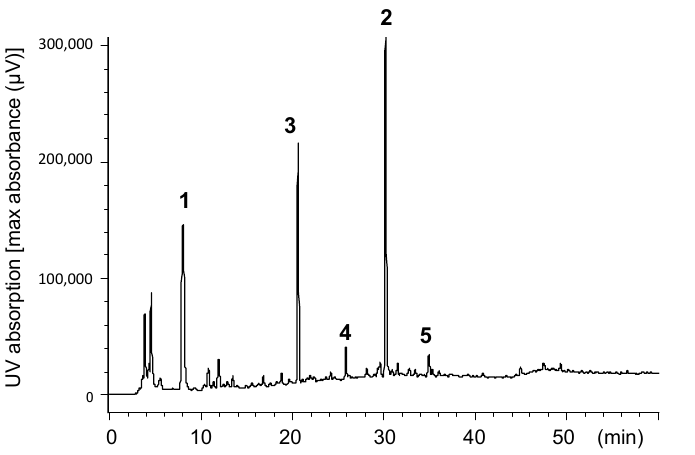
Figure 1. HPLC profile of insect tea: ( 1 ) Gallic acid; ( 2 ) ellagic acid; ( 3 ) brevifolin carboxylic acid; ( 4 ) brevifolin; ( 5 ) kaempferol 3- O -glucuronide.